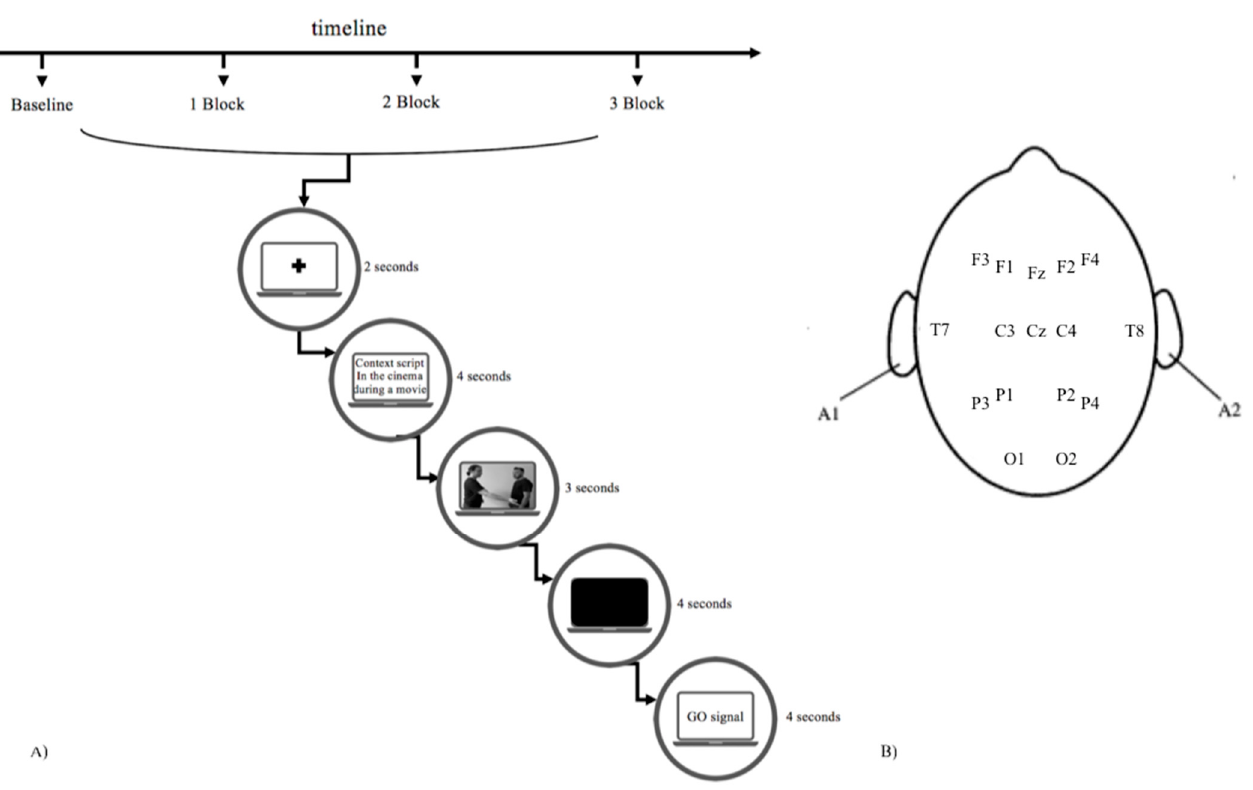
Figure 1. ( A ) Experimental procedure for the task administration. The figure shows the trial structure used in the three task blocks. ( B ) The figure shows the location of EEG channels. The electrodes were located in the following positions: F3, F1, Fz, F2, F4, T7, C3, Cz, C4, T8, P3, P1, P2, P4, O1, and O2.